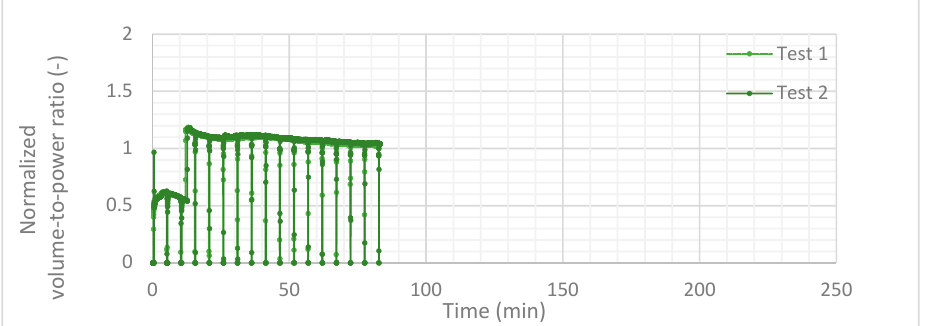
Figure A14. Normalized volume-to-power ratio at the thermostatic temperature of − 10 °C.